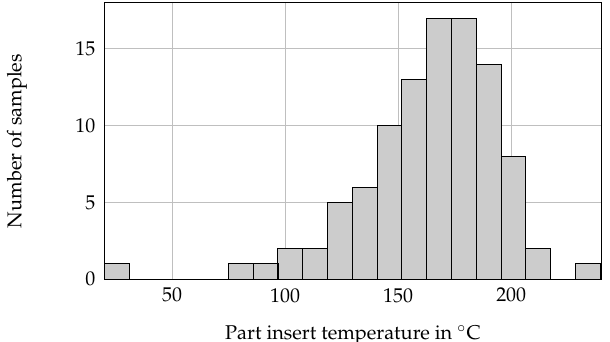
Figure 4. Histogram of part insert temperature samples within the